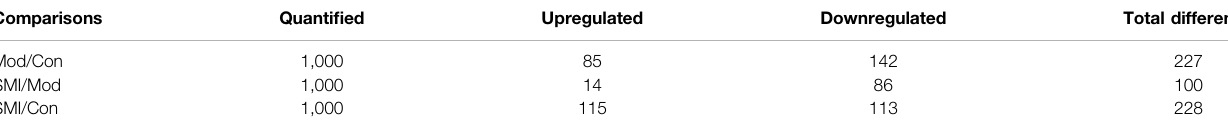
TABLE 1 | Number of differentially expressed proteins (DEPs) identi fi ed among groups in TMT-based proteomic analysis.